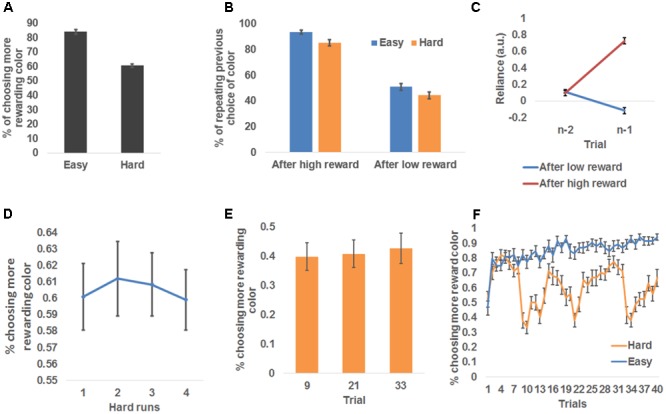
Behavioral results. (A) Group mean ± standard error of the percentage of choosing the more rewarding color, plotted as a function of run difficulty. (B) Group mean ± standard error of the percentage of repeating the previous trial’s choice, plotted as a function of reward magnitude and run difficulty. (C) Group mean and standard error of the dependence of the choice at trial n on choice history, plotted as a function of whether a high reward was received at trial n-1 and trial n-2. (D) Group mean and standard error of the percentage of choosing the more rewarding color, plotted as a function of the temporal order of hard runs. (E) Group mean and standard error of the percentage of choosing the more rewarding color, plotted as a function of the three trials (No. 9, 21, and 33) that immediately follow the change of the more rewarding color in hard runs. (F) Group mean and standard error of the percentage of choosing the more rewarding color, plotted as a function of trials in easy and hard runs separately.